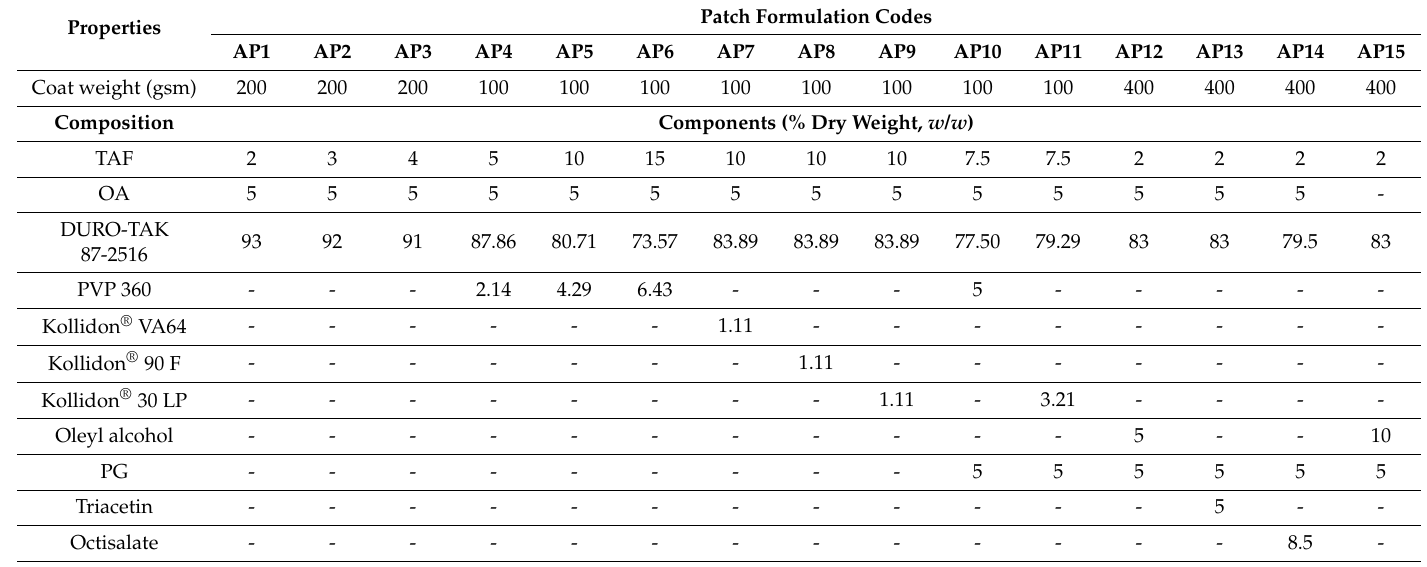
Table 1. Composition of acrylate based Tenofovir alafenamide fumarate (TAF) transdermal